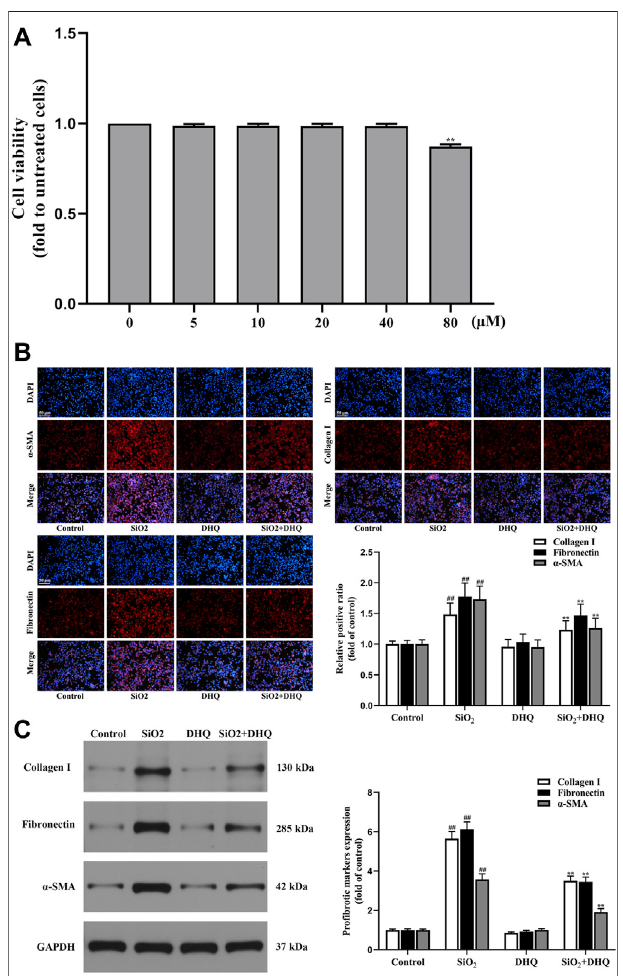
FIGURE 2 | DHQ inhibited pro fi brotic markers in fi broblasts. (A) Effects of WEL (0 – 80 µM) on cell viability were determined by the MTT assays, ** p < 0.01 vs. the 40 µM. (B) Representative images ( × 200) of immuno fl uorescence analysis of α -SMA, collagen I and fi bronectin in MRC-5 cells. Bar = 50 μ M. (C) The protein levels of α -SMA, collagen I and fi bronectin in MRC-5 cells were measured by western blotting. D Data are shown asmean±SD( n =3). # p < 0.05,## p < 0.01vs. thecontrolgroup; * p < 0.05, ** p < 0.01 vs. the SiO 2